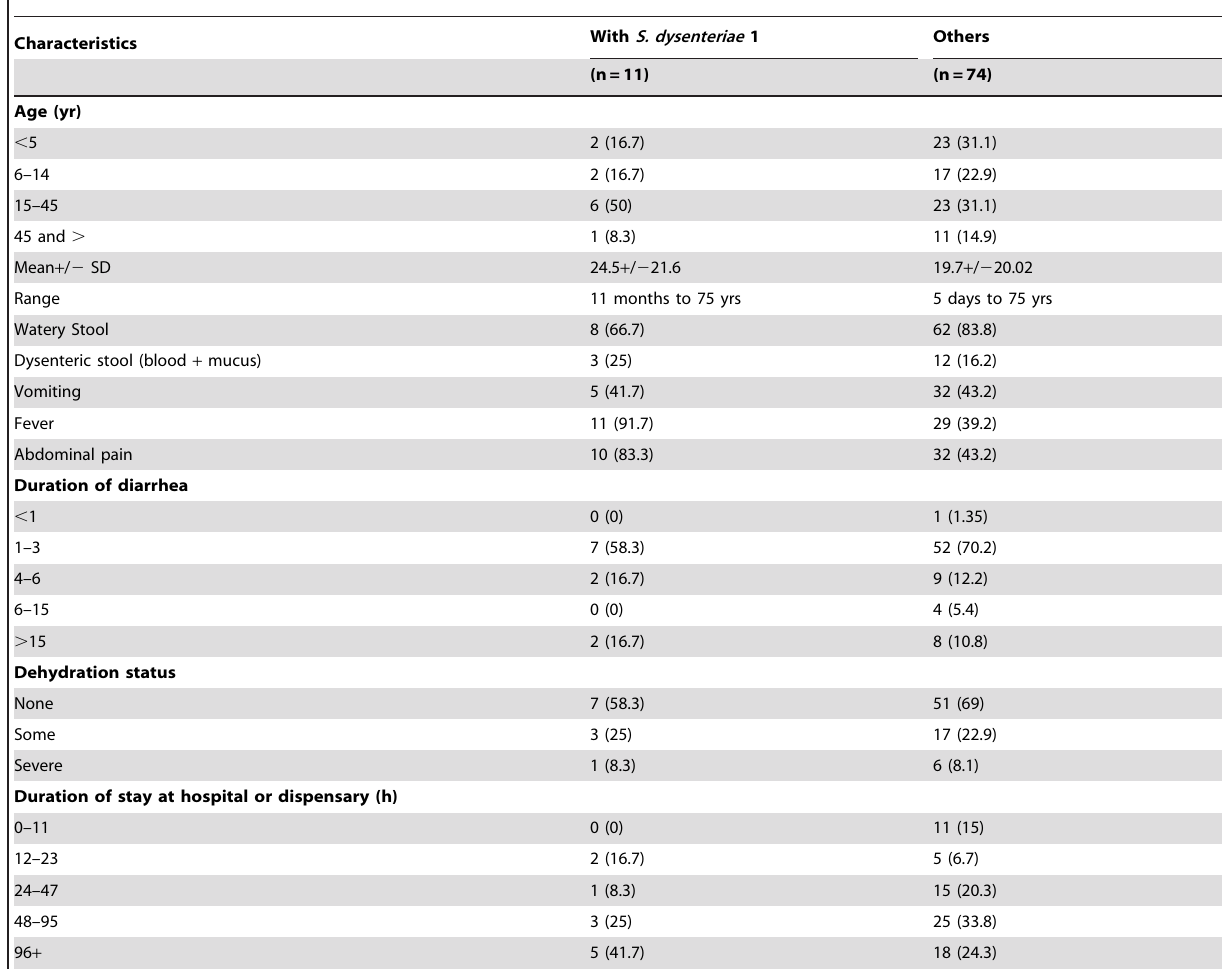
Table 1. Clinical characteristics of patients from India